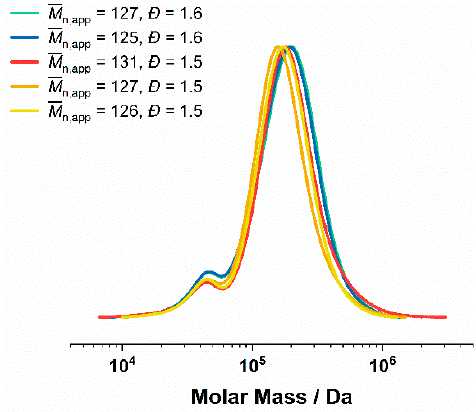
Figure 4. GPC of P(DMA- co -NIPAM)- b -PS synthesized via RAFT emulsion polymerization in water/1,4-dioxane 80:20 (20% w / w ) using either P(DMA 148 -NIPAM 127 ) 29 or P(DMA 199 -NIPAM 171 ) 39 as mCTA. M n,app (determined by DMAc GPC calibrated with PS standards) and dispersity of the respective GPC curve are shown in the legend. Impurities due to residues of the random copolymer (mCTA P(DMA 148 -NIPAM 127 ) or P(DMA 199 -NIPAM 171 )) can be detected in the GPC traces.